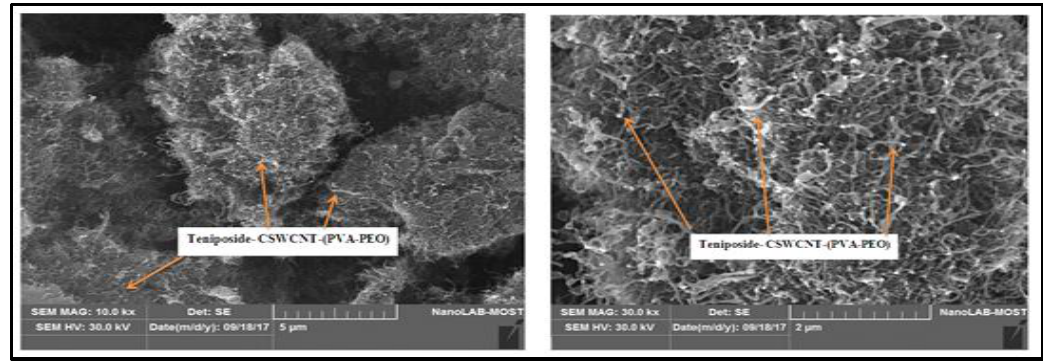
Figure (3) SEM images of teniposide-CSWCNT-(PVA-PEO) Transmission electron microscopy for CSWCNT- (PVA-PEO )